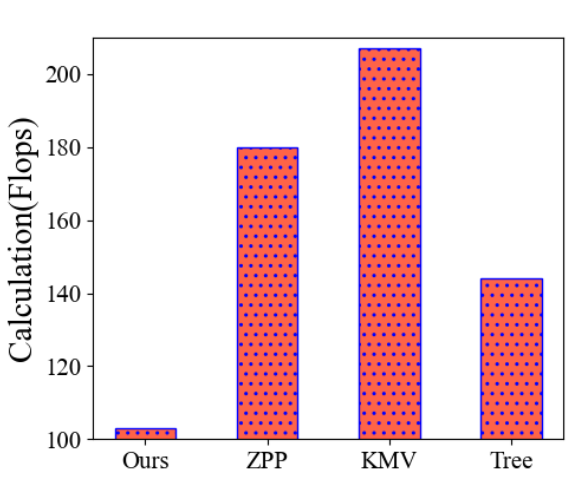
Figure 9. Comparison of the computational size of different models.